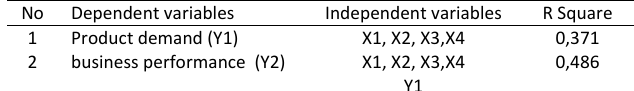
Fig. 2. Flow chart of the study concept Table 4: Model validity evaluation results Fig. 2: Flow chart of the study concept Table 4. Model validity evaluation